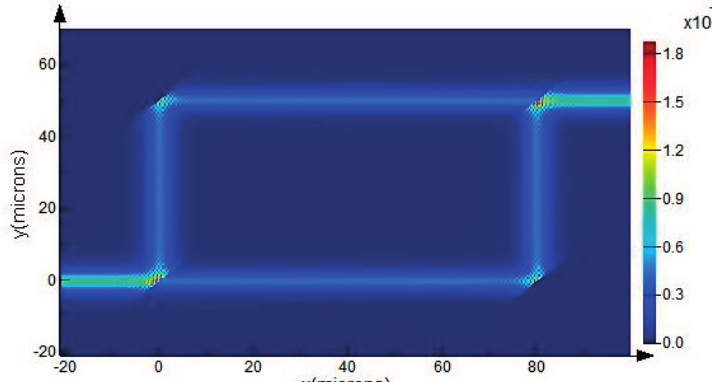
Figure 14. The optical power map of the MZI structure with the fundamental EH-polarized mode of an SOI rib waveguide with H = 10 μ m, h = 5 μ m, w = 2.5 μ m at wavelength of 1550 nm. Because there is no phase difference between the sensing arm and the reference arm, only the port “output 1” has an output signal.